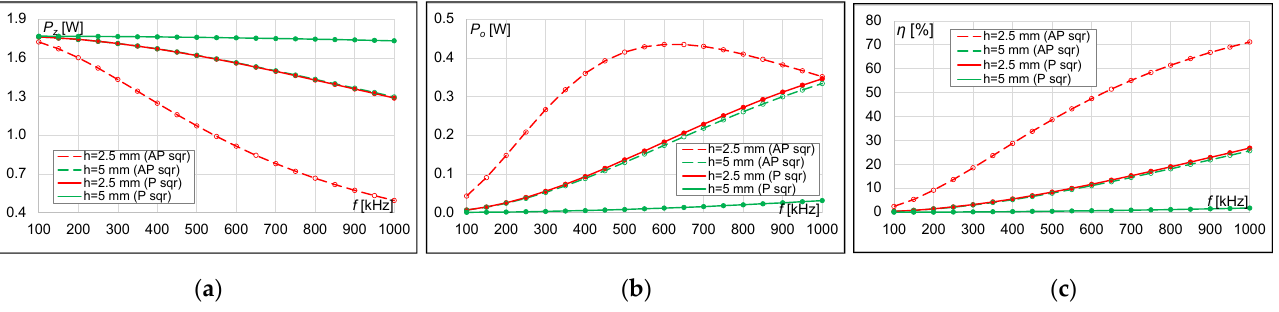
Figure 13. Results for square coils with r = 5 mm and the number of turns n = 20 at two distances ( h = 2.5 mm and h = 5 mm): ( a ) transmitter power, ( b ) receiver power, ( c ) power transfer efficiency.